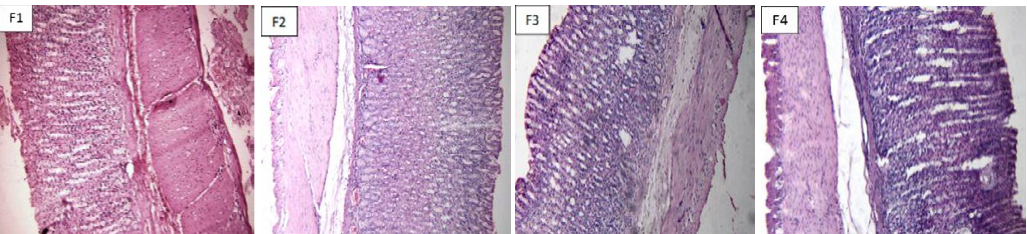
Fig. 7. Photomicrographs of stomach sections obtained from rats exposed to different concentrations of IONs. (F2, F3, F4) control rats received 50, 500, 5000 mg/kg of IONs, respectively (F1, F2, F3, F4): normal stomach, (Staining with hematoxylin and eosin). Magnification: 40 x for panels.